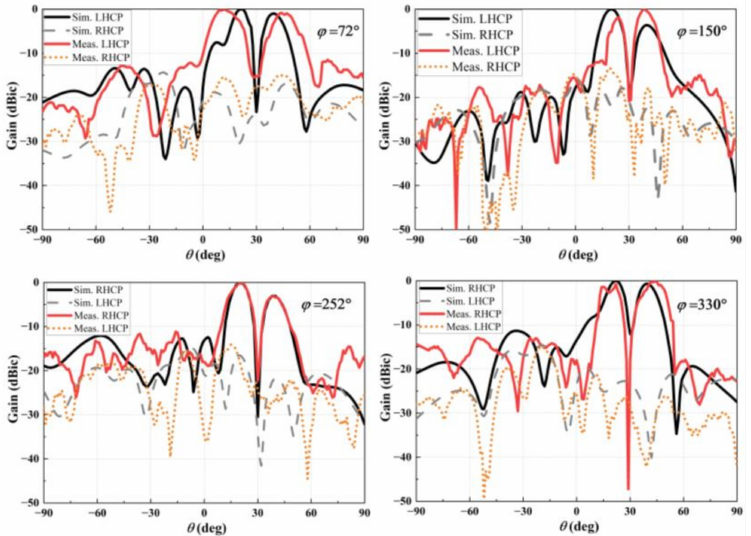
Figure 12. Numerical far-field patterns of the LHCP and RHCP beams in the φ ( A , L ) = 72 ◦ ; φ ( B , L ) = 150 ◦ ; φ ( B , R ) = 252 ◦ ; and φ ( A , R ) = 330 ◦ planes at 10 GHz.